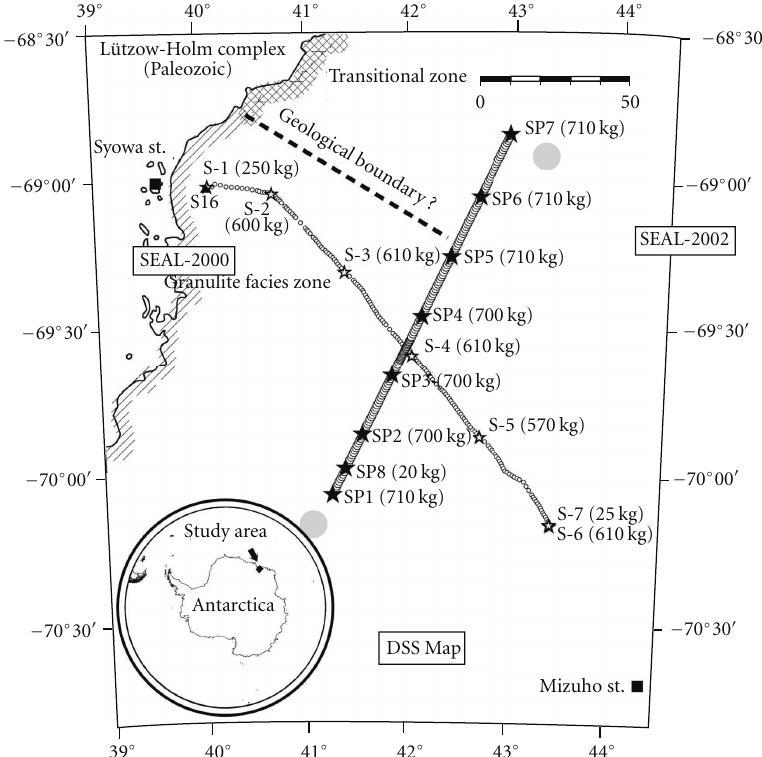
Figure 11: Map showing the location of DSS in LHB (after Kanao et al. 2010 [17]). Solid and open stars indicate the shot locations in SEAL-2002 and -2000, respectively. Large and small circles represent the geophone stations on ice sheet for both the DSS operations. The size of each shot given is weight of dynamite